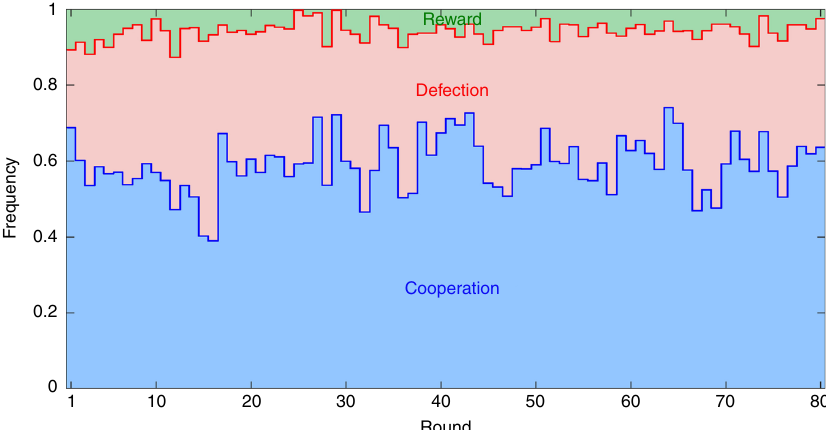
Fig. 2 Initial burst of cooperation caused by the decoy option is stable in time. Shown are the frequencies of all three actions as they evolve through time in the decoy treatment. These frequencies were obtained by counting how many volunteers chose a particular action divided by the total number of volunteers playing. Treating the frequency of cooperation C as a time series, we executed the augmented Dickey – Fuller test to examine the statistical stationarity of this series. Denoting the frequency of C at time t with C t , the augmented Dickey – Fuller test consisted of two steps. First, we fi tted equation